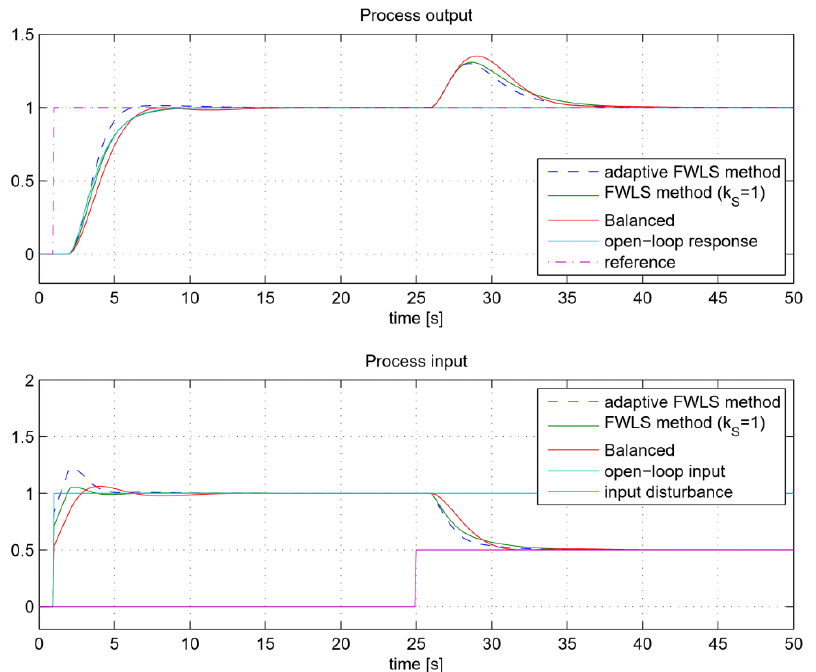
Figure 26. The closed-loop tracking and control signals for process G P 6 when using FLWS, adaptive FLWS and Balanced method.